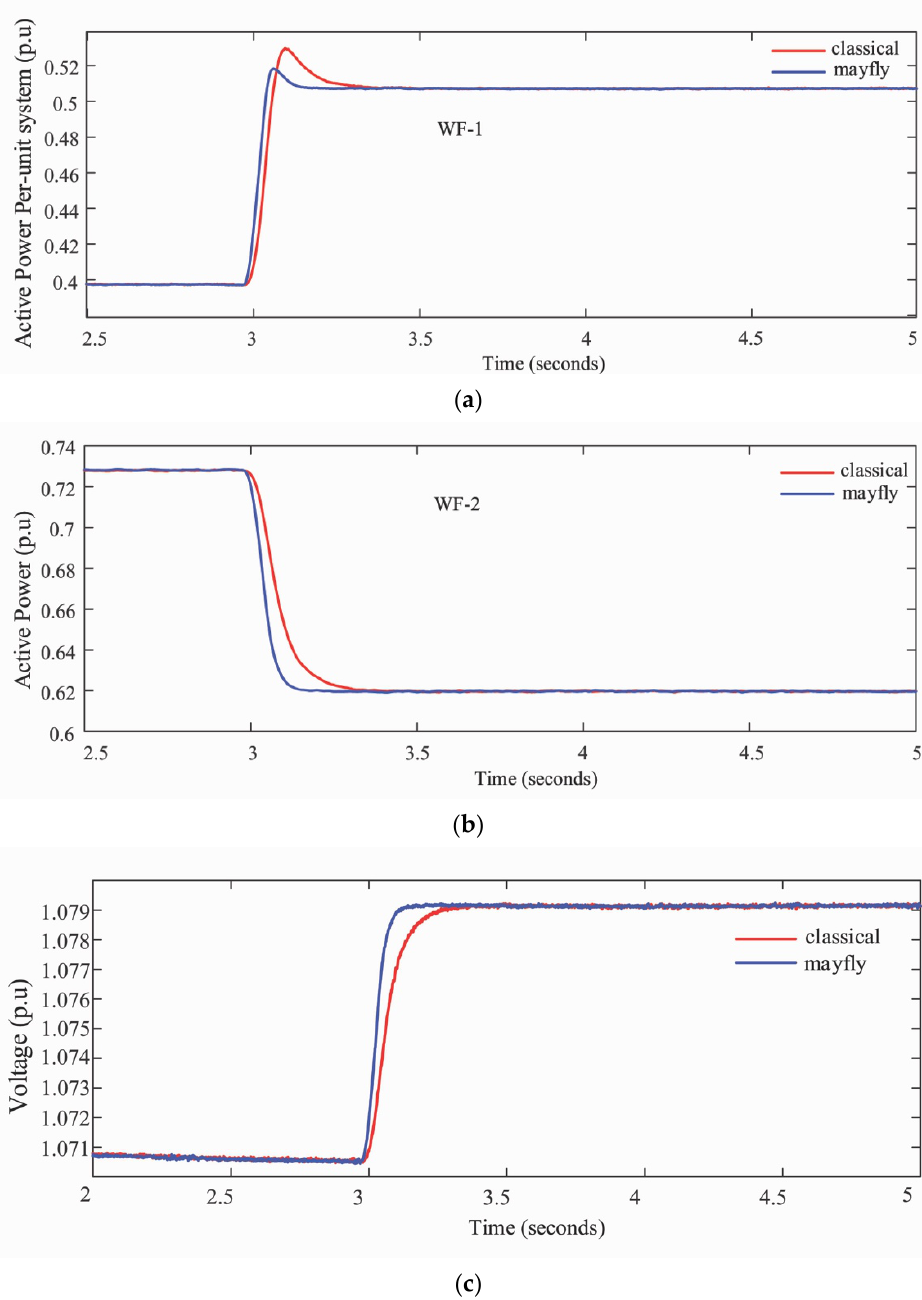
Figure 14. Change in power at wind farms ( a ) The change at wind farm 1. ( b ) The change at wind farm 2. ( c ) The change at DC-link voltage due to the wind farm 1 .